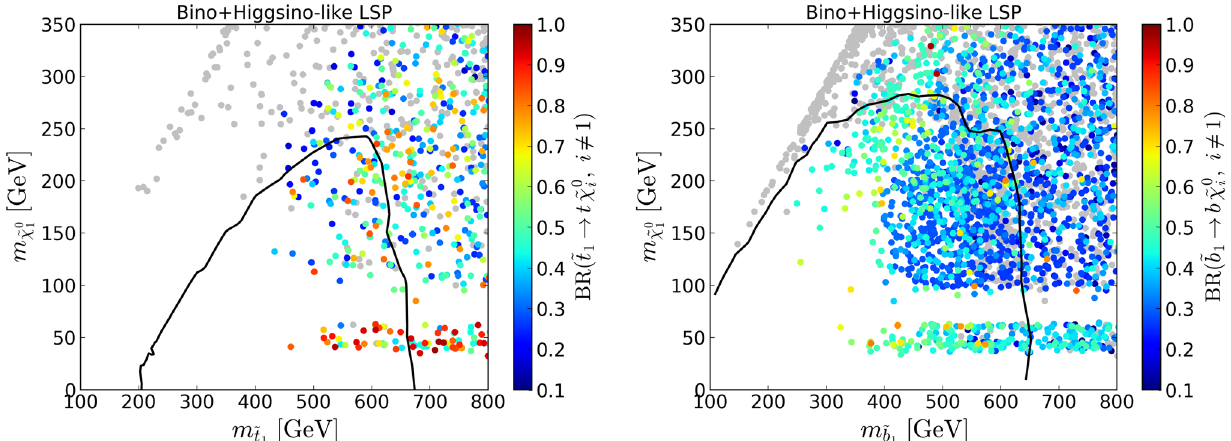
Fig. 10 Branching ratios of stop (left) and sbottom (right) decays into heavier neutralino mass eigenstates for SModelS -allowed points, lead- ing to signatures for which no SMS results are currently available − m ≥ 5 GeV). Here, bino- and higgsino-like LSP scenarios ( m ˜ χ 0 ˜ χ 0 i (cid:6)= 1 1 Fraction of Bino+Higgsino LSP ATLAS excluded points excluded by SModelS